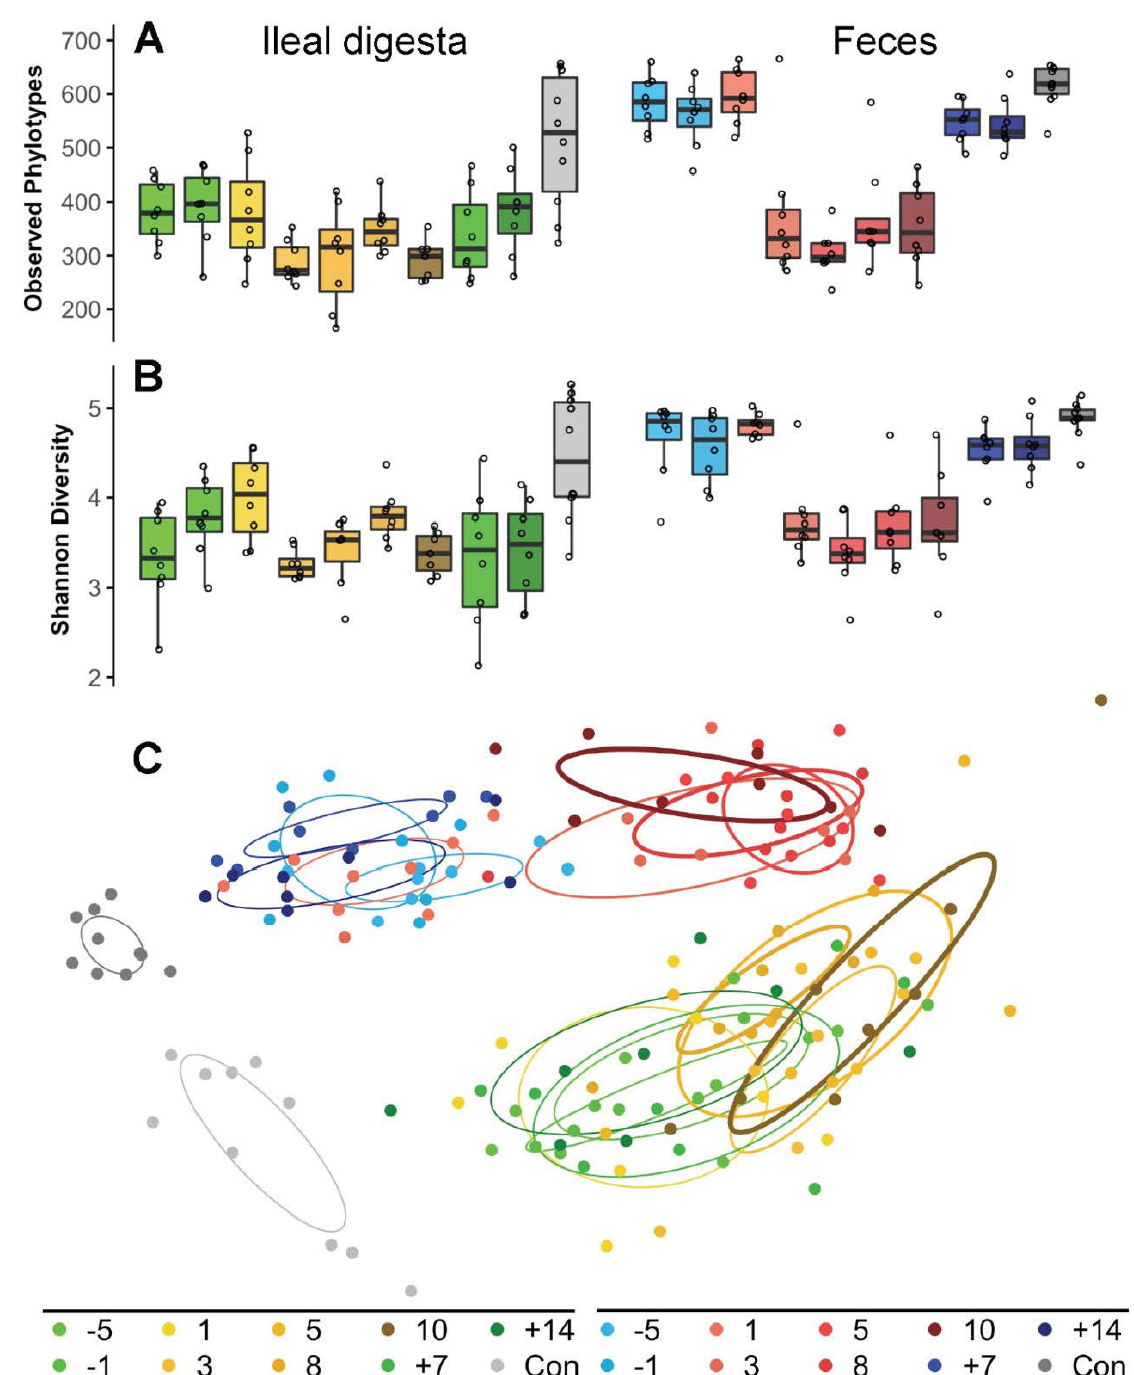
Figure 2. Diversity alterations in bacterial richness (number of phylotypes) ( A ) and Shannon diver- sity ( B ) as well as ordination analysis of community composition (non-metric multidimensional scaling analysis) ( C ) in ileal digesta and fecal samples at baseline, during enzyme withdrawal and after enzyme reintroduction. Key to colors indicating sampling site (ileal digesta: shades of yel- low/green and feces: shades of blue/red) and sampling time points (days before ( − )/during/after(+) PERT withdrawal) is provided at the bottom. Results from Control pigs (Con) are also provided (grey colors).